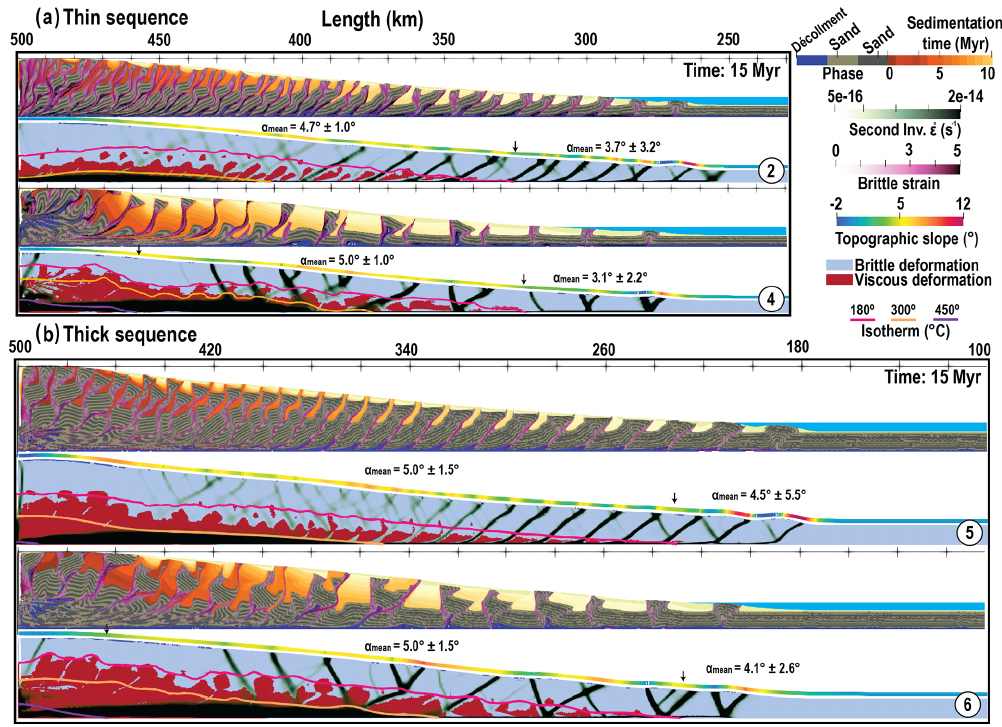
Figure 5. Models with no shear heating after 15Myr of shortening for (a) thin and (b) thick sequence pile models. Normal sedimentation rate use in M2 and M5 , and high erosion rate in M4 and M6 . Refer to Fig. 2 for color codes and Tables 1 and 2 for experiment parameters, 1:1 scale.